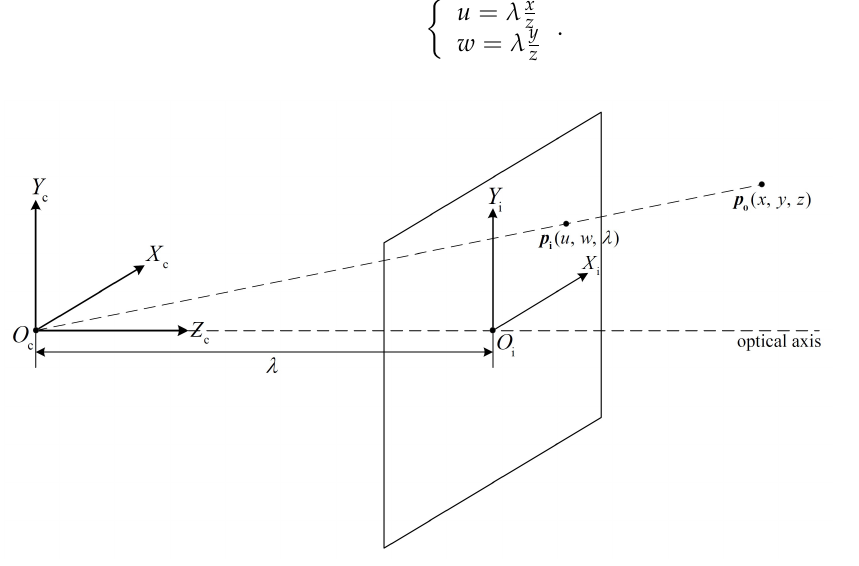
Figure 6. Frontal pinhole projection